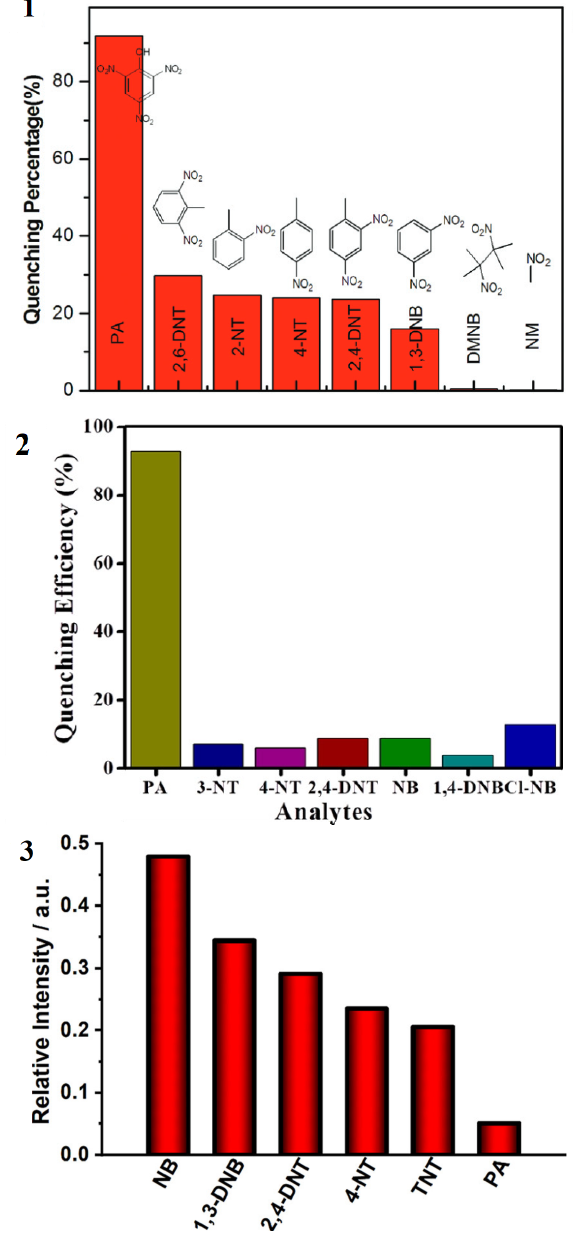
Figure 4. ( 1 ) The luminescence responses of large-porous Eu-MOF dispersed in DMF for nitro compounds. Reprinted with permission of the Royal Society of Chemistry from [79].